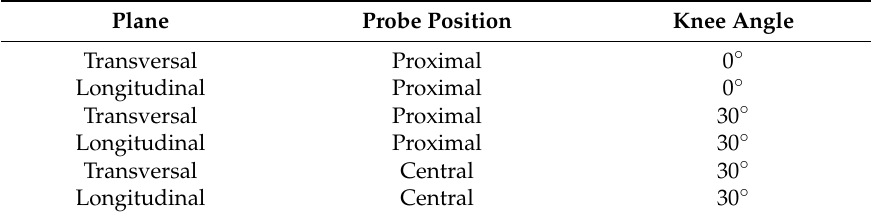
Table 1. Tendon B-mode image acquisition protocol for dominant and non-dominant